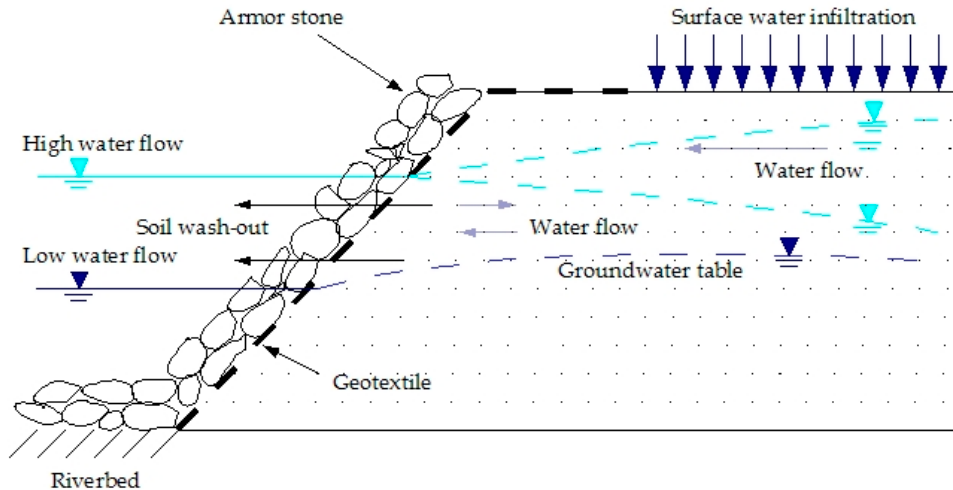
Figure 2. Directions of water flow depending on the water level and the groundwater table.